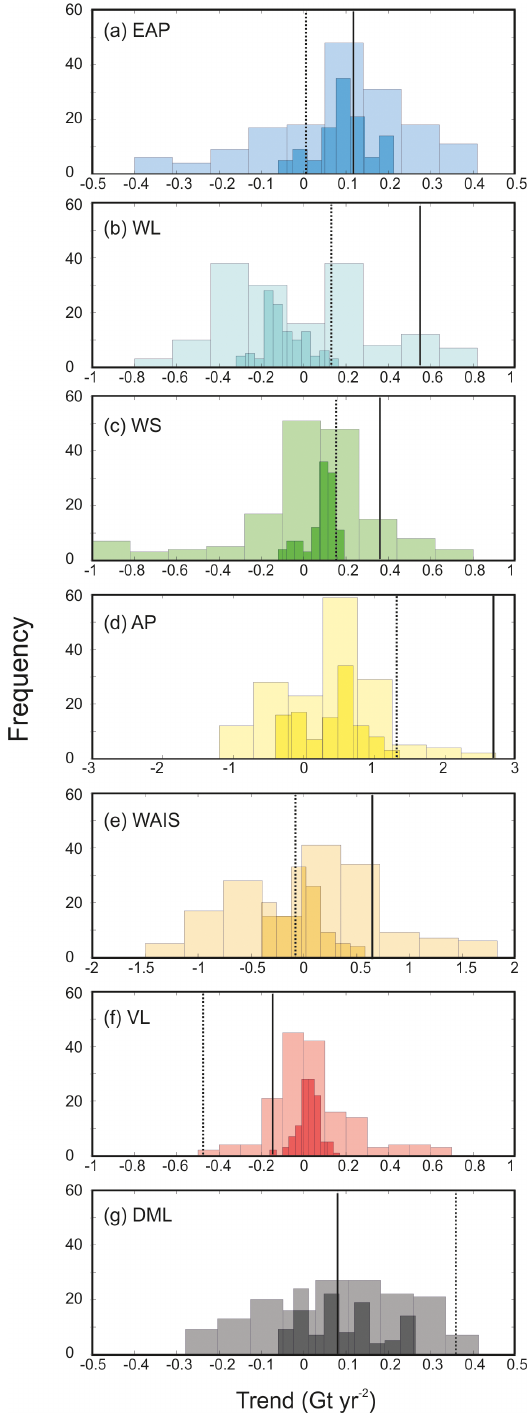
Figure 8. Histogram of running 50-year (lighter shading) and 100- year (darker shading) trends for each region (mmw.e.yr − 1 ). The solid vertical line represents the most recent 50-year trend and the dashed vertical line the most recent 100-year trend (2010–1961 and 2010–1911,